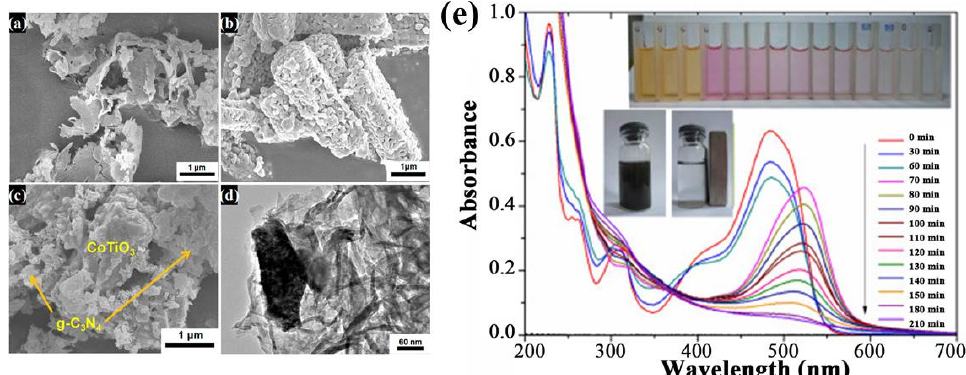
Figure 14. SEM images of ( a ) g-C 3 N 4 , ( b ) CoTiO 3, ( c ) CT-U and ( d ) 0.15% CT-U. Used with permission from [149]. Copyright 2016 American Chemical Society; ( e ) the photodegradation of Orange II by CuFe 2 O 4 @C 3 N 4 /H 2 O 2 /Vis system (inset: the solution before and after magnetic separation using an external magnet). Used with permission from [150]. Copyright 2015 Elsevier.